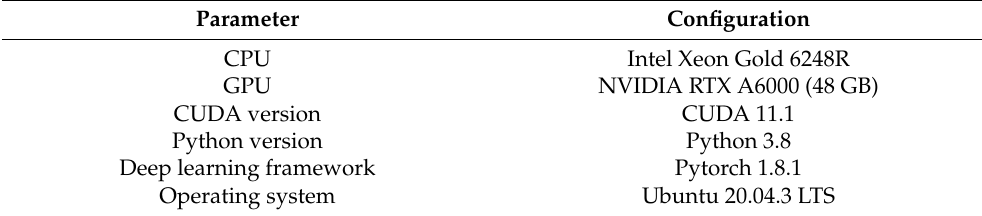
Table 1. Experimental equipment and environmental settings.